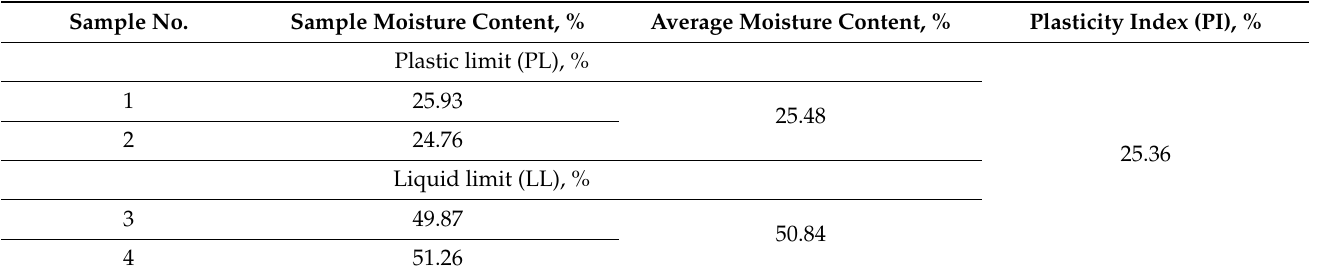
Table 2. Characterization of clay soil according to Atterberg’s